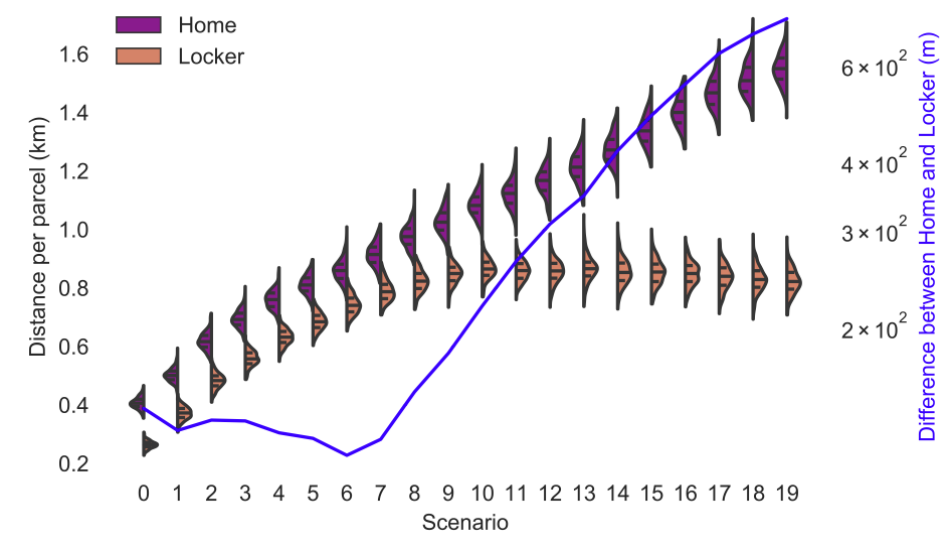
Figure 1. Distance per parcel for delivery to lockers (delivery van) and customer’s homes as well as the difference between both delivery types.